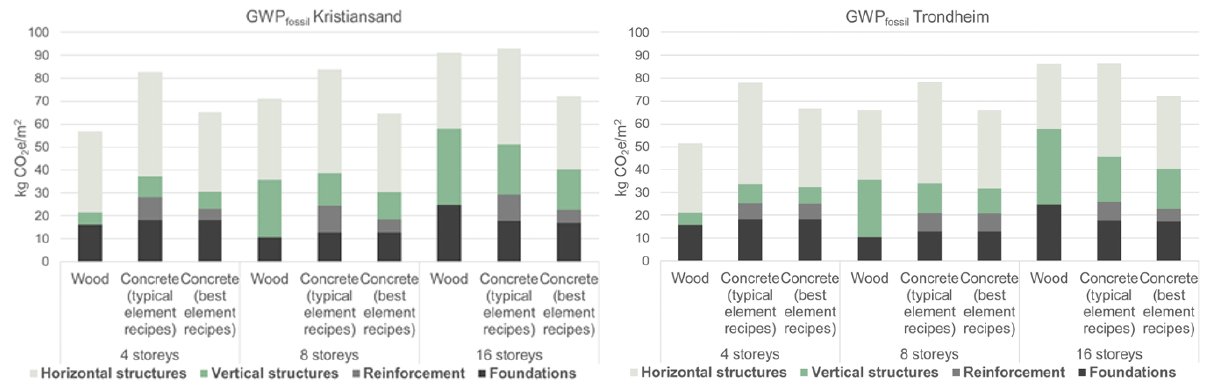
Figure 2. Fossil GHG emissions for three alternative load-bearing structures located in Kristiansand and Trondheim given as kg CO 2 e/m